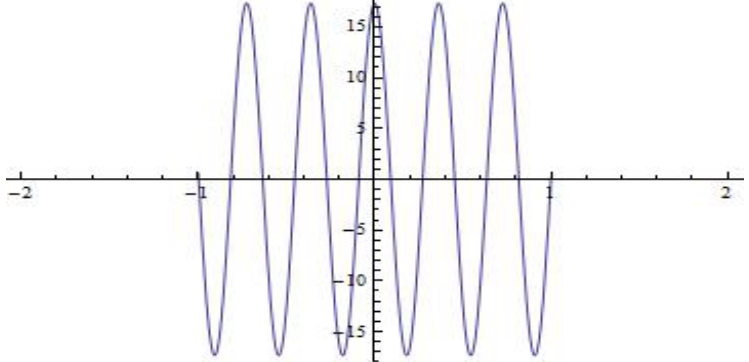
Figure 4. Graph of the first fundamental solution y = φ ( x , λ ) , for λ = 300. (This graph was sketched by using “Mathematica